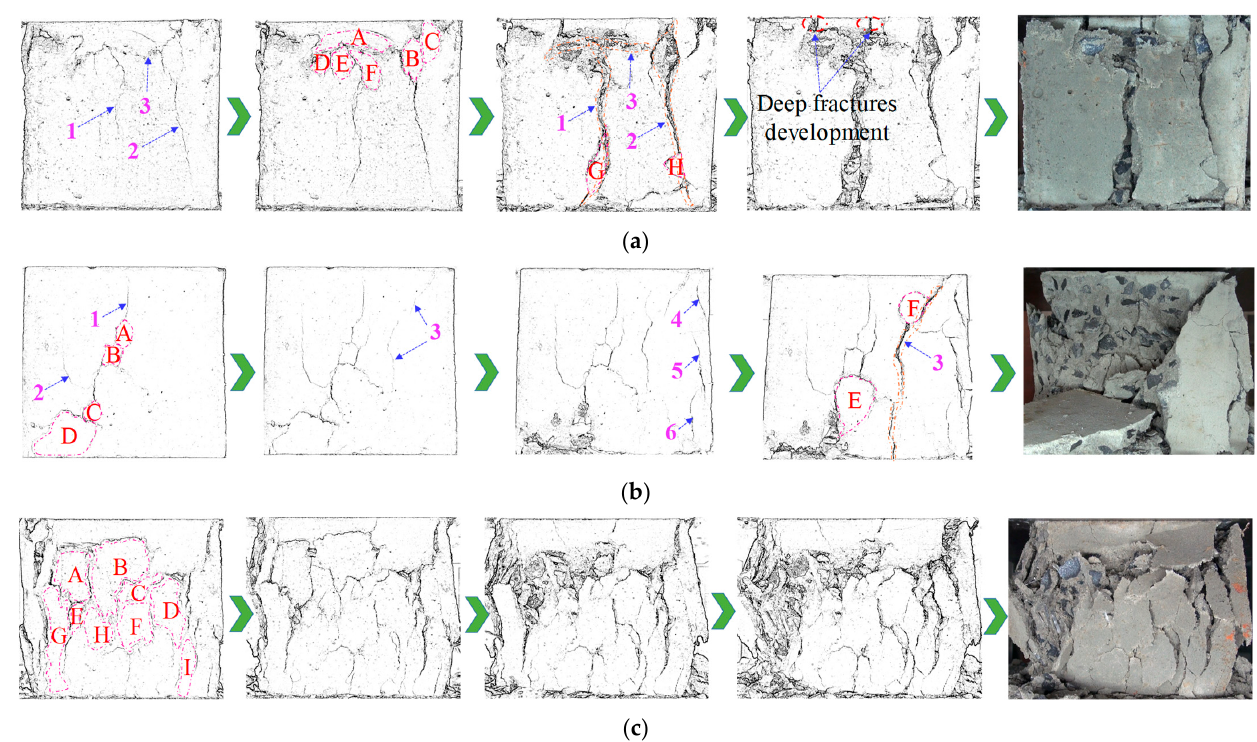
Figure 10. Fracture evolution characteristics of RBB samples: ( a ) Samples without FA and SF; ( b ) Samples containing FA and without SF; ( c ) Samples without FA and containing SF.